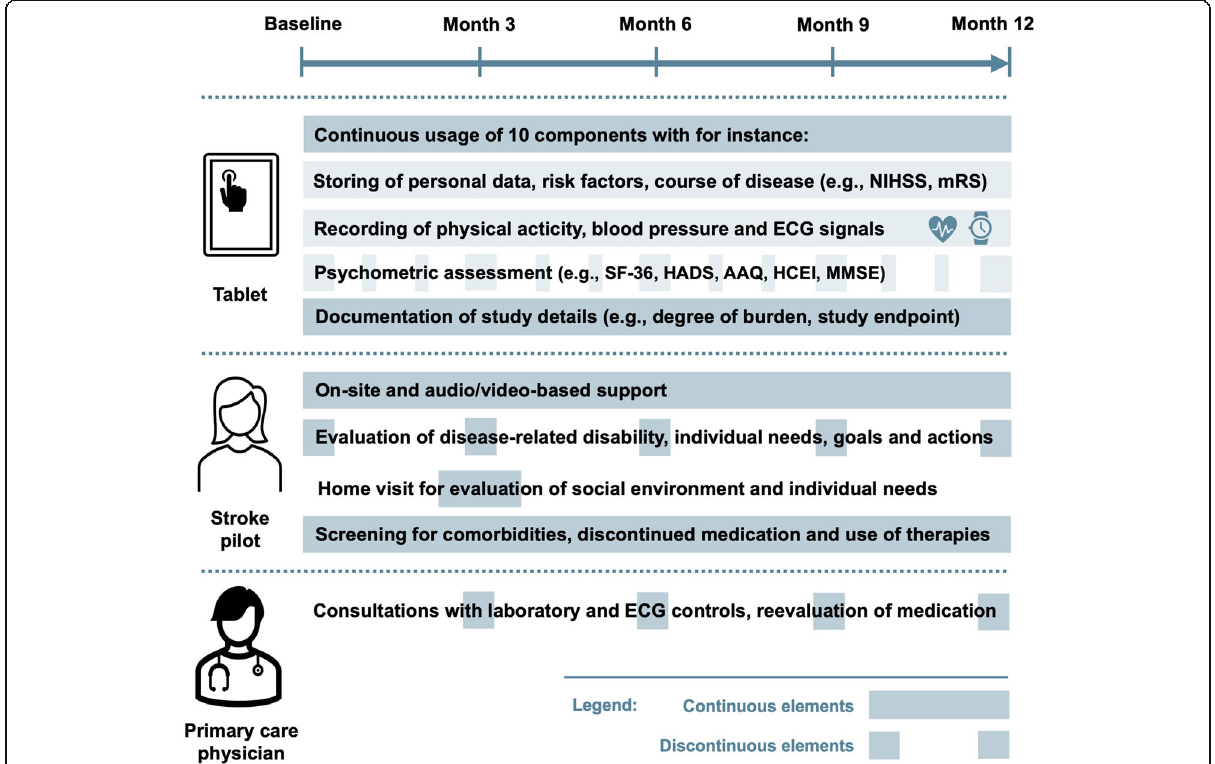
Fig. 3 Overview of the PostStroke-Manager feasibility study. During a follow-up period of one year, visits are planned in 3-months-intervals, allowing direct interactions between the stroke pilot and the patients, while in the meantime communications will typically be arranged via the digital system. Abbreviations: NIHSS: National institutes of health stroke Scale, mRS: modified Rankin scale, SF-36: Short form (36) health survey, HADS: Hospital anxiety and depression scale, AAQ: Adherence assessment questionnaire, HCEI: Healthcare empowerment inventory, MMSE: Mini mental status examination, ECG: electrocardiography. The figure including icons was created with Microsoft PowerPoint and Word for Mac (version 16.47, 2021, Microsoft, Redmond,